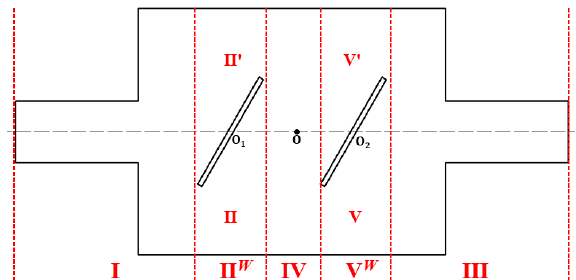
Figure 5. The REC with double baffles distributed axially.